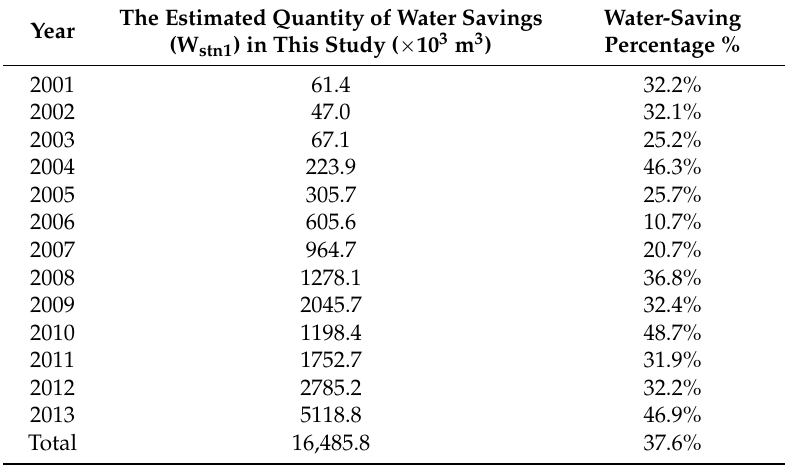
Table 5. Comparison of estimated values for the water-saving effects of